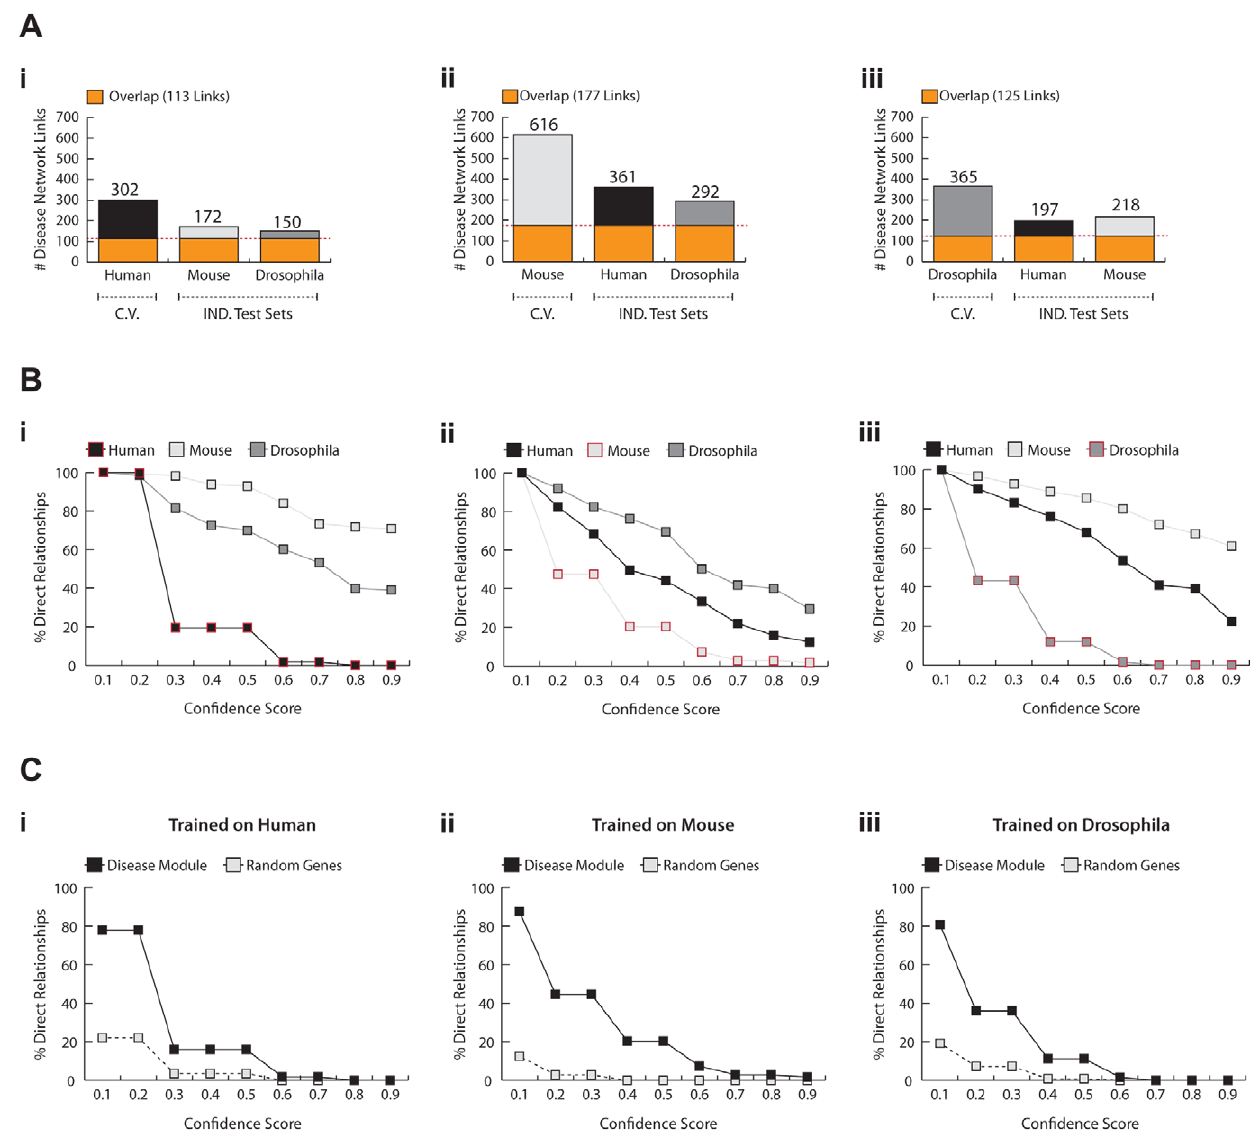
Figure 5. Translatability and robustness of interspecies disease networks. A ) The number of links that were found during interspecies translation and optimization of the disease networks per individual datasets. The red dash-line depicts the number and fraction of links that can be found in all species with the confidence threshold of 0.1. The translatability of disease networks learnt and trained on human ( i ), mouse ( ii ), and Drosophila ( iii ) are presented separately. The cross-validation set which is used during the training phase is depicted by C.V. and the independent test sets are grouped as IND. Test Sets . B ) The translatability of relationships over series of different confidence thresholds. These line plots demonstrate the percentage of relationships with confidence score higher than the threshold. For the independent testing datasets the ratio is towards the number of links that were expected to be found after generation of the network map. C ) The robustness of disease networks are assessed according to the level of connectivity for genes encoding for the proteasome as compared to the set of randomly selected genes at different